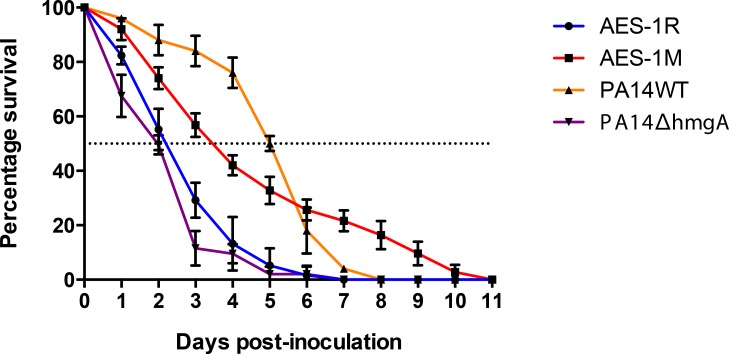

C. elegans virulence assay.Percent survival of C. elegans (n = 50) when grown on a lawn of P. aeruginosa AES-1R, AES-1M, PA14 and PA14ΔhmgA. The dotted line indicates the LT50 (mean time at which 50% of the worms were killed by ingesting P. aeruginosa). The individual points are the means of six biological replicates for AES-1 stains and three biological replicates for PA14 strains. The error bars represent the standard error of the means.